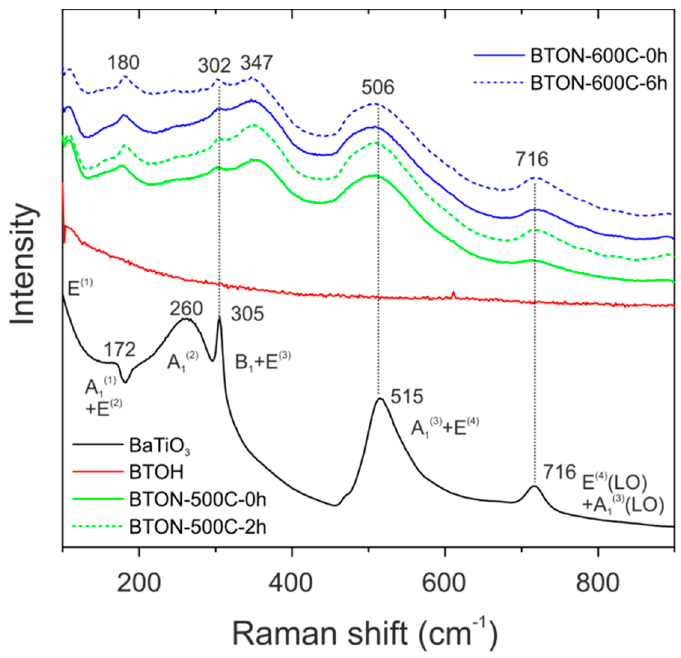
Figure 6. Compilation of Raman spectra for BaTiO 3 , BTOH, BTON-500C-0 h, BTON-500C-2 h, BTON-600C-0 h, and BTON-600C-6 h.